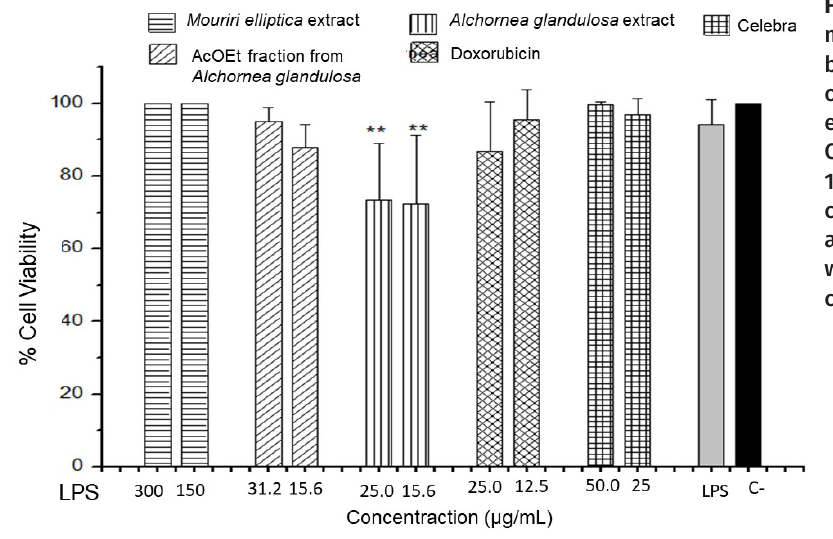
Figure 1. Viability of peritoneal macrophages of Ehrlich tumor- bearing mice in the presence of different concentrations of extracts, fractions and drugs. Cells in culture medium (RPMI- 1640) were used as negative control (C-) and LPS solution as positive control. ** P < 0.001 when compared to the negative